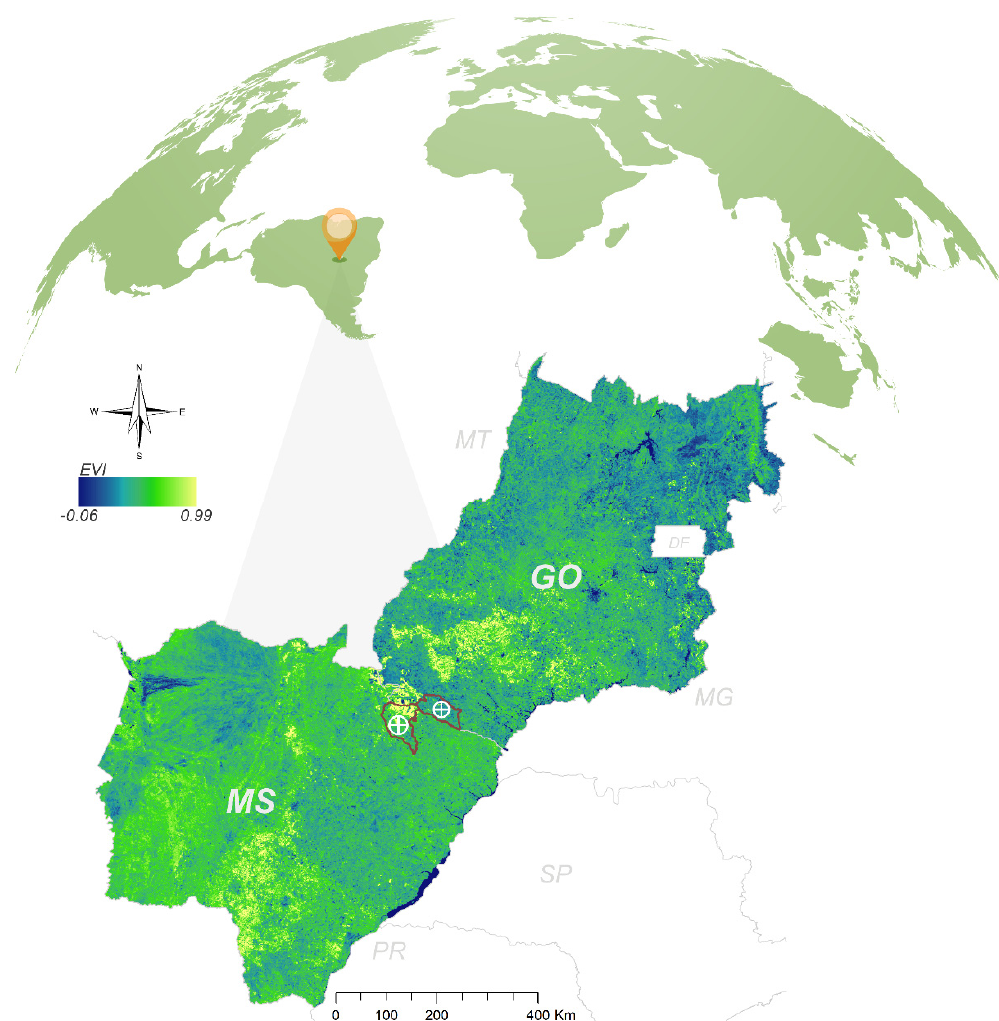
Figure 1. Location of the studied areas in Chapadão do Sul (MS) and Aporé (GO), Brazil. EVI = enhanced vegetation index. The variables evaluated in each trial were: plant height (PH, cm), days to maturity (DM), and grain yield (GY, kg ha − 1 ). PH was obtained with the aid of a tape measure, measuring from the base of the plant to its apex. The DM was obtained by counting the number of days between emergence and maturation of more than 90% of the plants in the plot. Grain yield was obtained by harvesting 2 m long of the central row from each plot, weighing the grains, correcting for 13% moisture, and extrapolating to kg ha − 1